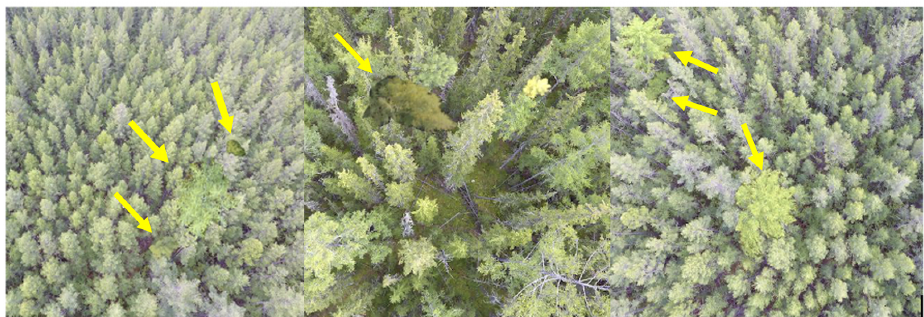
Figure 23. Examples of unnatural-looking generated images in the synthetic image dataset, the red arrows show the cutout larch trees that were placed over the UAV